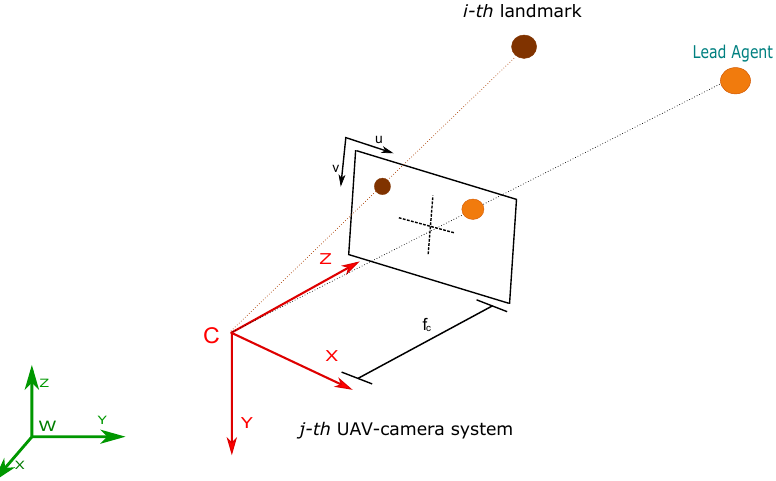
Figure 3. Pinhole camera projection